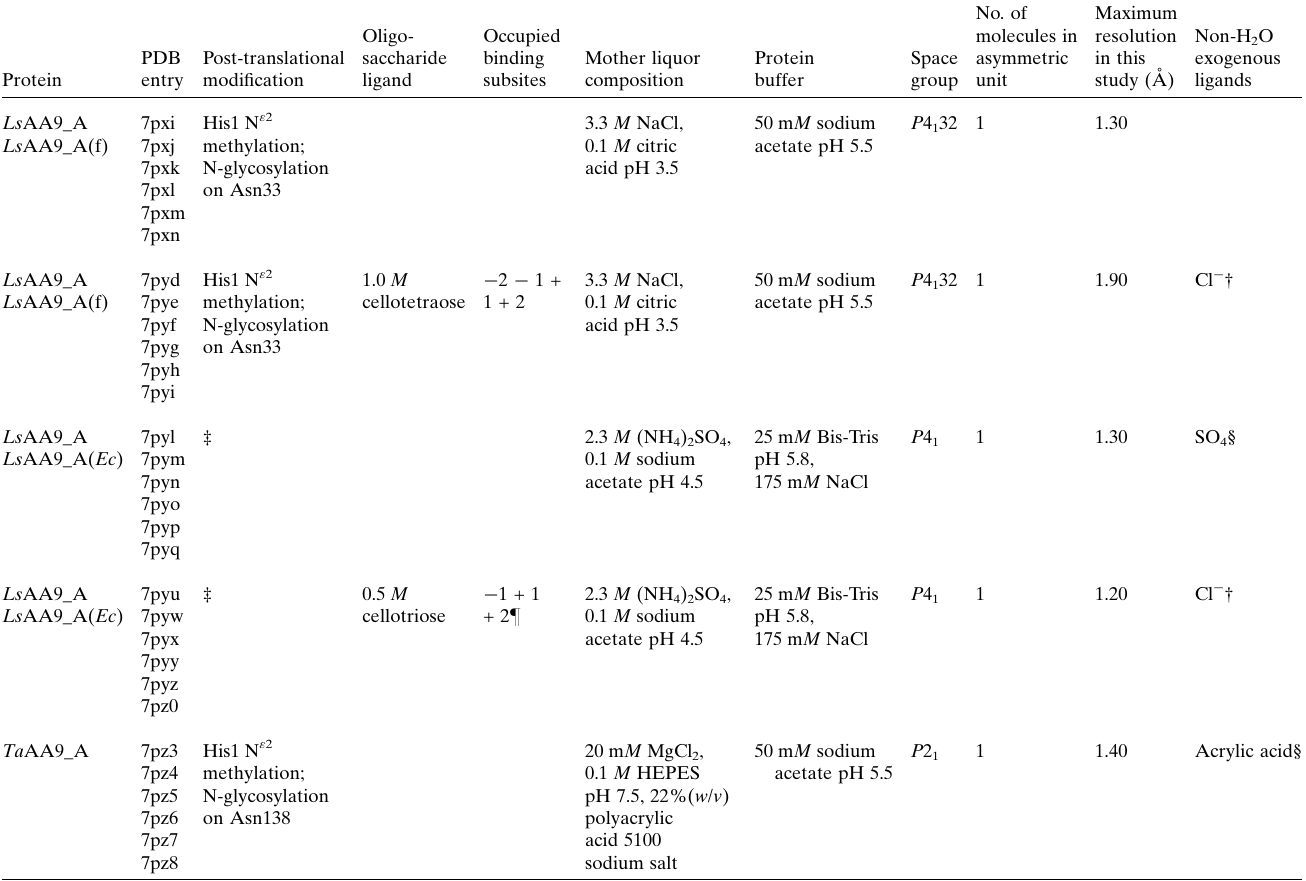
Table 2 A brief overview of the proteins and crystals used in this study.